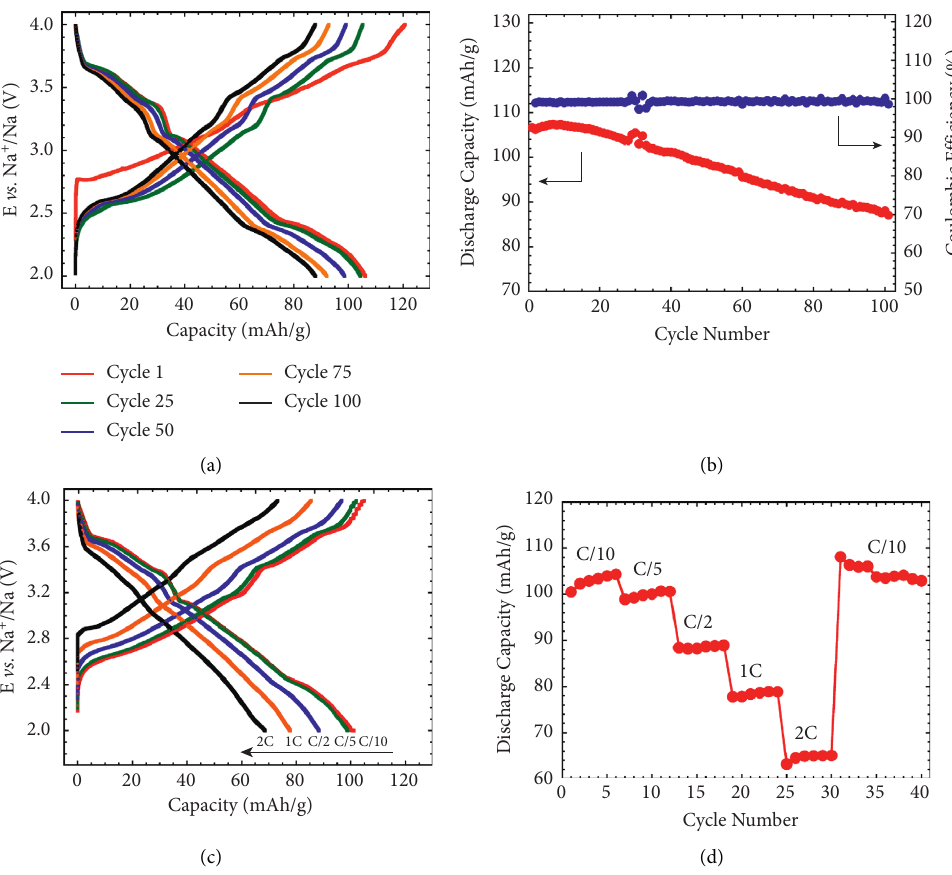
Figure 4: (a) Charge/discharge curves of the P2/P3-NaNMC electrode at a current density of C/10. (b) Discharge capacity and Coulombic efficiency versus cycle number for the electrode. (c) Voltage profile of material at various current densities. (d) The rate capability of the